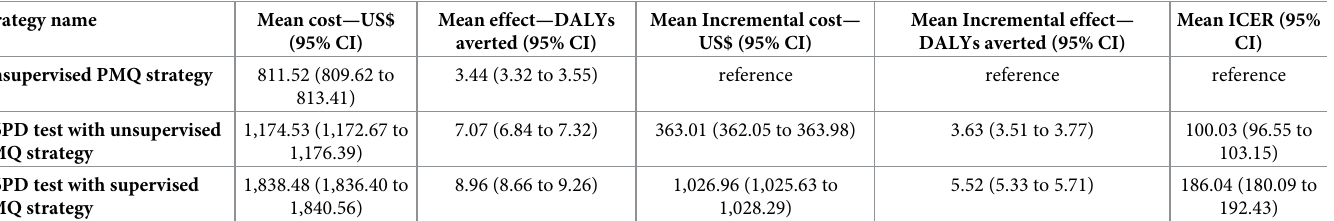
Table 5. Probabilistic sensitivity analysis